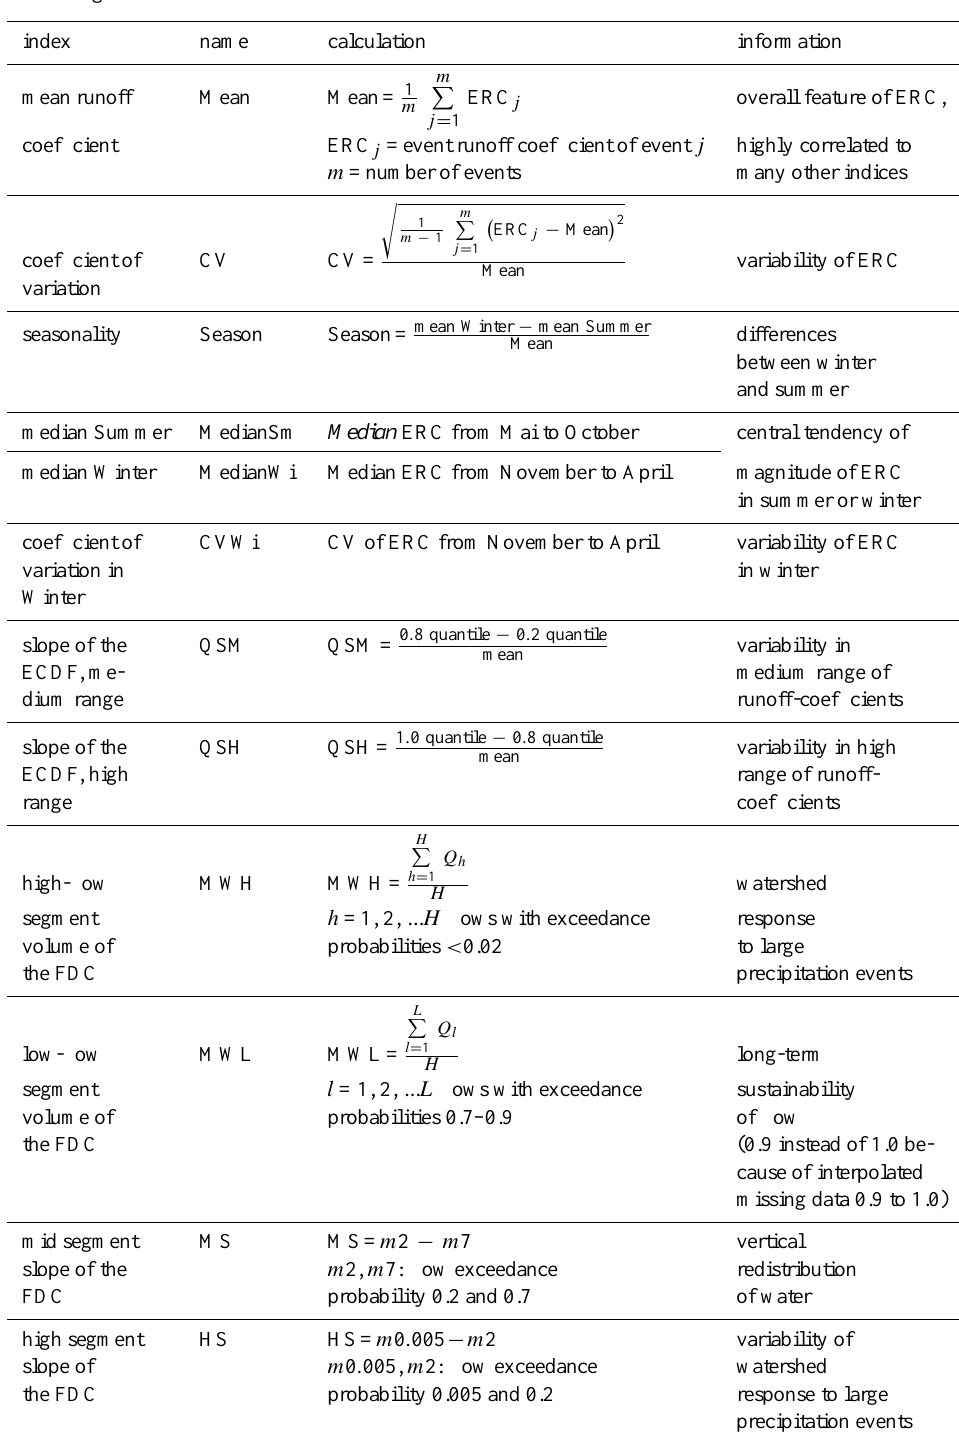
Table 1. Indices describing catchment